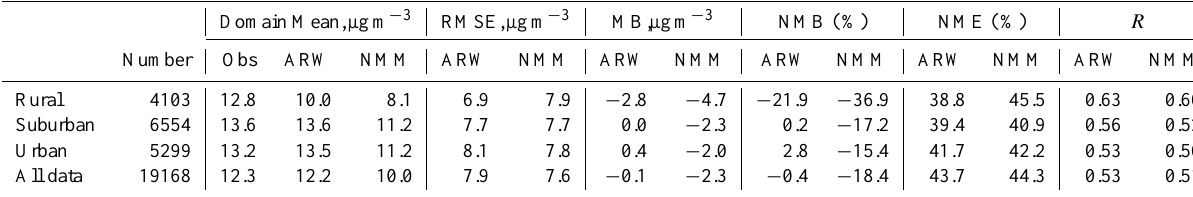
Table 1. Comparison of ARW-CMAQ and NMM-CMAQ models for operational evaluation of daily PM 2 . 5 concentrations on the basis of the AQS data over the eastern United